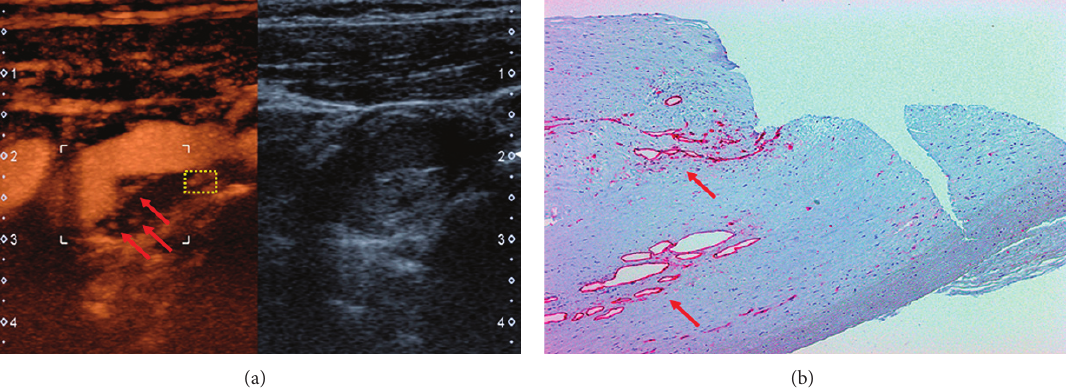
(a) (b) F 2: (a) Contrast-enhanced ultrasound (CEUS) of the carotid segment shown in Figure 1(a) (le). Intraplaque neovascularization is marked by red arrows. B-mode ultrasound of the same region (right). (b) Immunohistochemistry of CEA specimen corresponding to yellow- boxed area in (a). CD3 staining (red arrows) indicates plaque neovascularization.